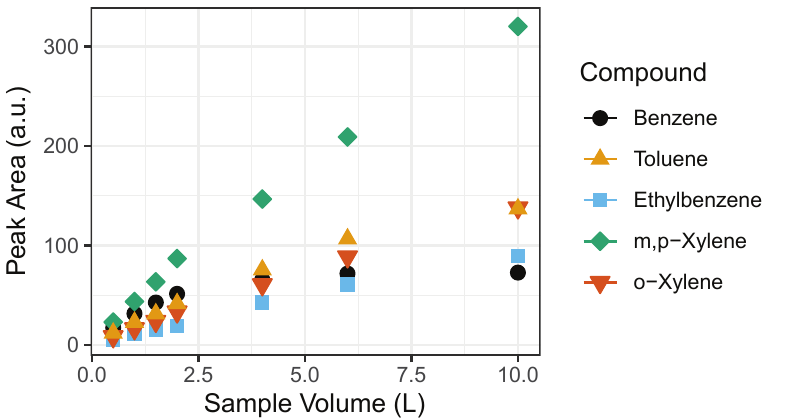
Figure 5. Linearity of detected signal to sampling volumes of BTEX compounds. Signal becomes saturated past 2 L, particularly evident for benzene. The error bars represent the standard deviation of the mean of triplicates of peak area. Note: error bars do not appear because they are smaller than the size of the